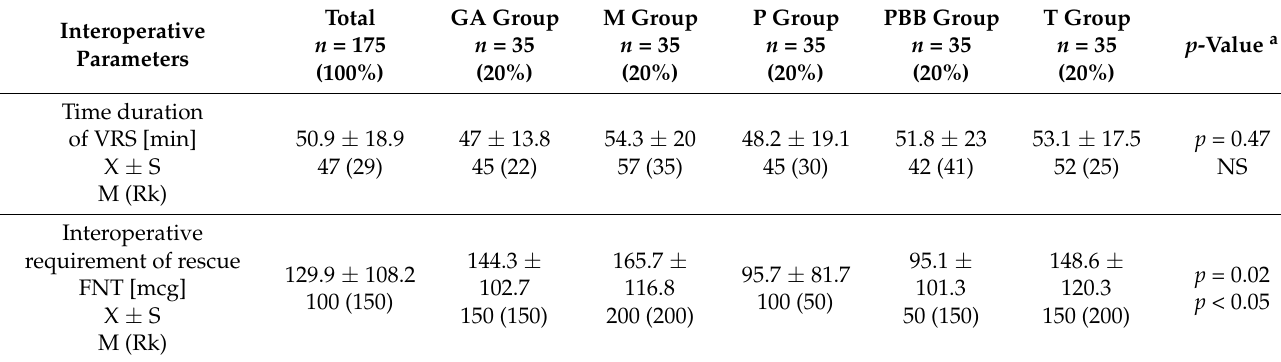
Table 3. Interoperative parameters.